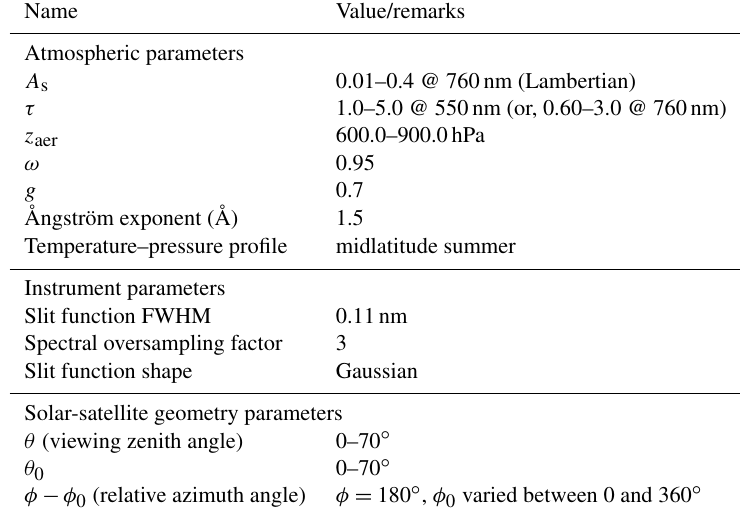
Table 1. Input parameters for synthetic